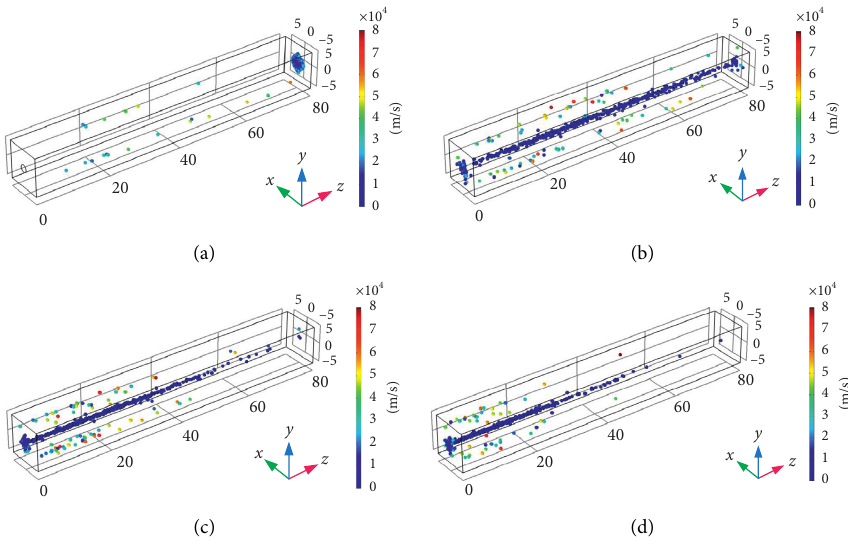
Figure 3: Ion states under different background pressures without drift gas flow: (a) p � 0Pa, (b) p � 10Pa, (c) p � 20Pa, and (d) p � 30Pa.